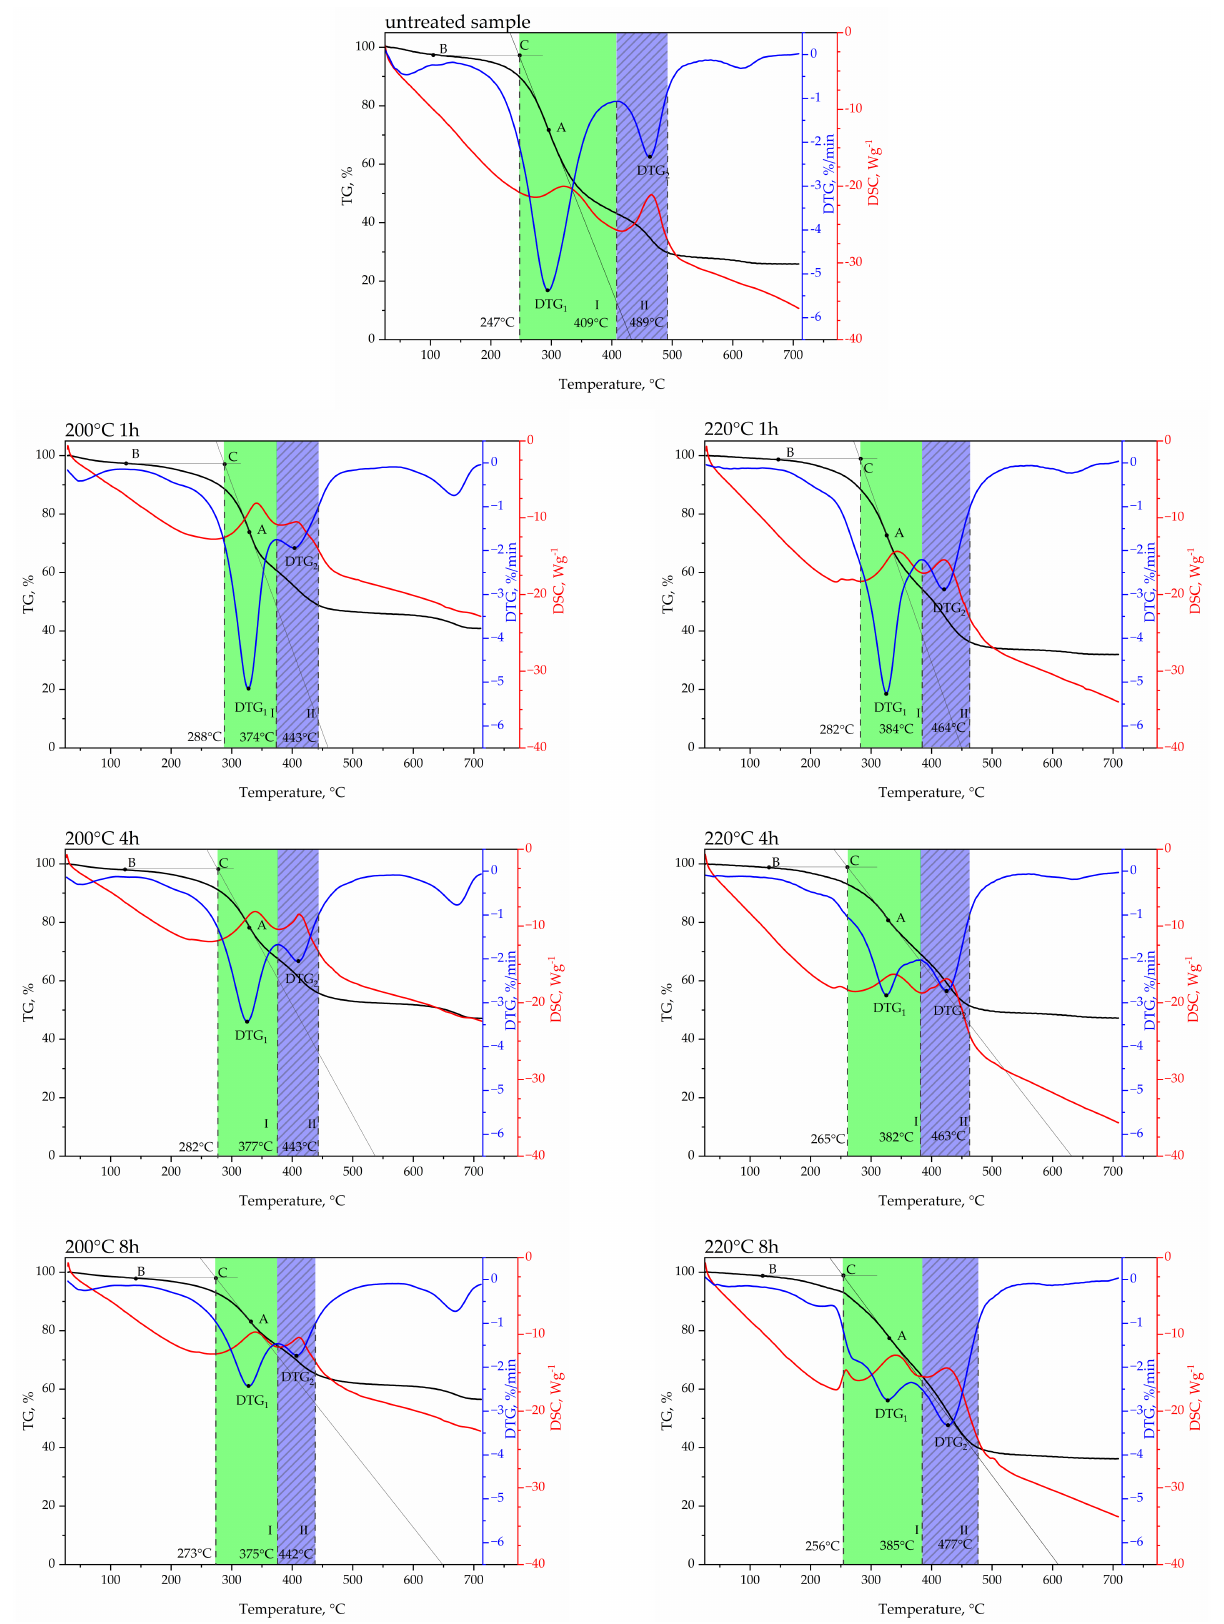
Figure 5. Summary of TG and DTG curves for each experiment conducted at 200 ◦ C and 220 ◦ C for 1, 4, and 8